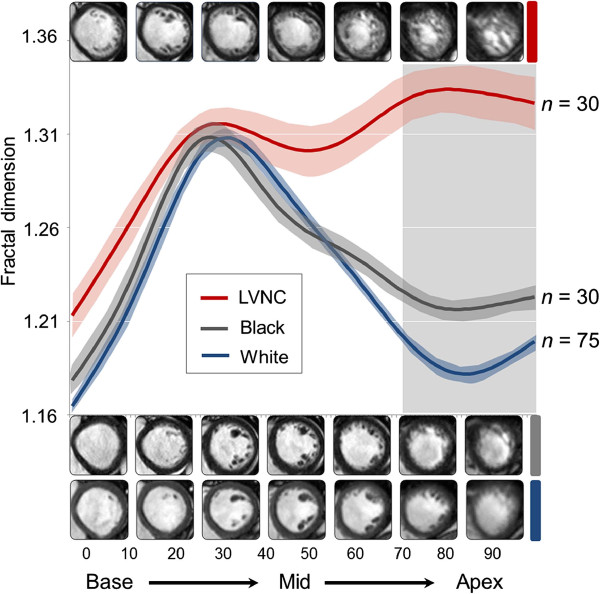
FD across the left ventricle from base to apex. This interpolated dataset summarizes regional differences in left ventricular trabecular complexity. Population mean FD (solid lines) and s.e.m. (shaded areas) are shown. The maximum difference between groups was observed in the apical third of the ventricle (vertical grey bar). Illustrative end-diastolic CMR slices are shown for each of the three populations. CMR = cardiovascular magnetic resonance; s.e.m. = standard error of mean; other abbreviations as in Figure 1.